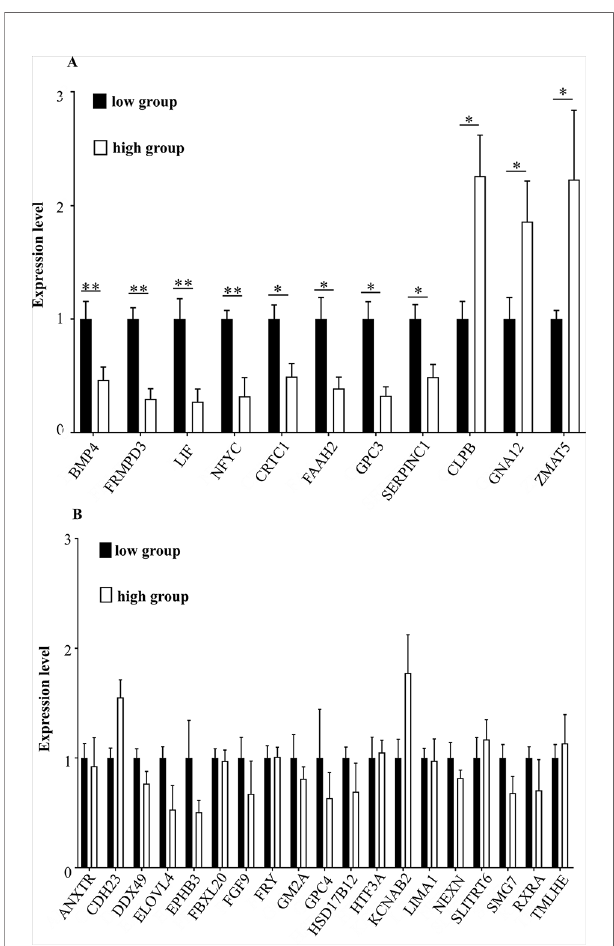
FIGURE 5 | (A, B) The mRNA expression levels of key genes in different groups. The horizontal axis shows the different genes, and mRNA expression levels are on the vertical axis. Sign ** indicates extreme signi fi cance ( P < 0.01). Sign * indicates signi fi cance ( P < 0.05). No marker means no